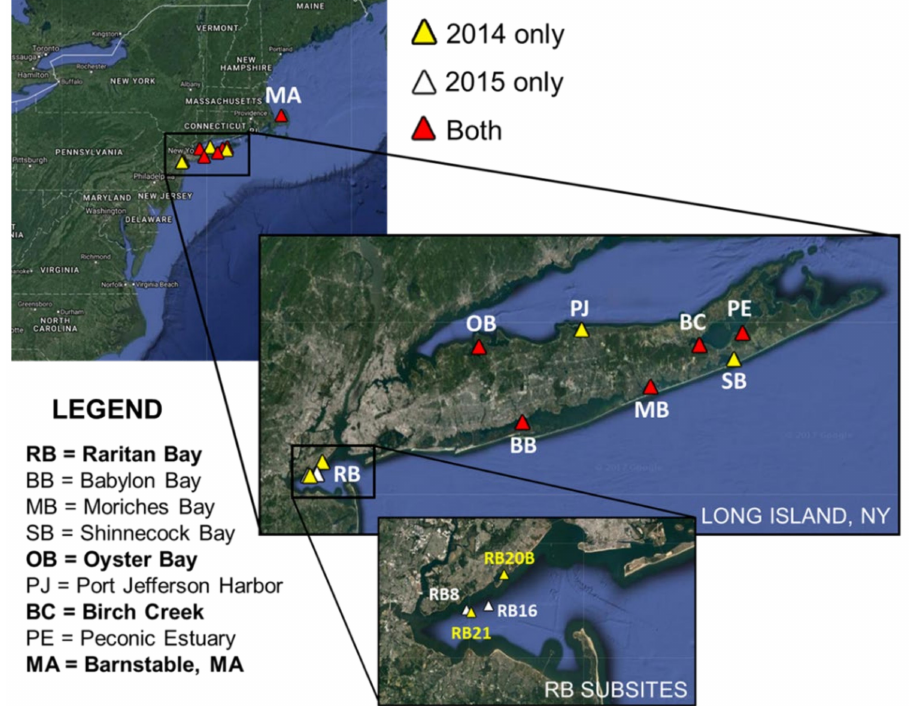
Figure 1. Location of sampling sites. Between 2014 and 2015, 12 sites were surveyed throughout the marine district of New York, including a control site in Barnstable, Massachusetts (MA). Four different locations within Raritan Bay (RB) were surveyed between the 2 years. Sites in bold on the legend (RB, OB, BC, and MA) have a previous history of QPX